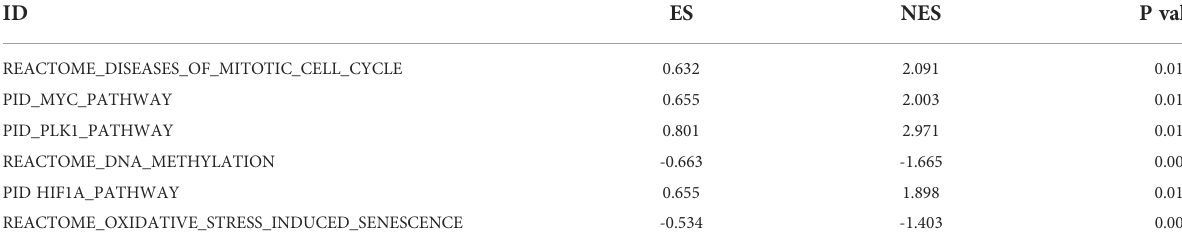
TABLE 2 Gene sets enriched in correlated with ECE2 mRNA expression